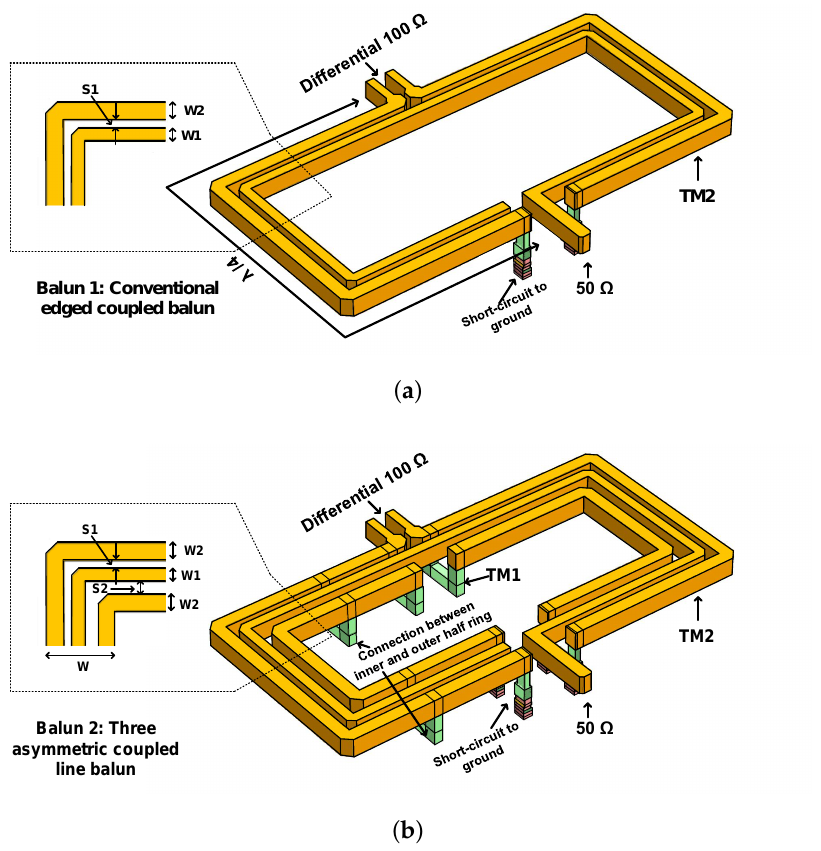
Figure 4. 3D views of the conventional edged couple balun ( a ) and a three asymmetric coupled lines balun ( b ), where different important parameters are shown. For the sake of simplicity, the ground plane is not shown. The size of each balun is 215 × 148 µ m 2 . Balun 1: conventional coupled line balun without the inner lines; Balun 2: the three asymmetric coupled lines balun. W, width; S,